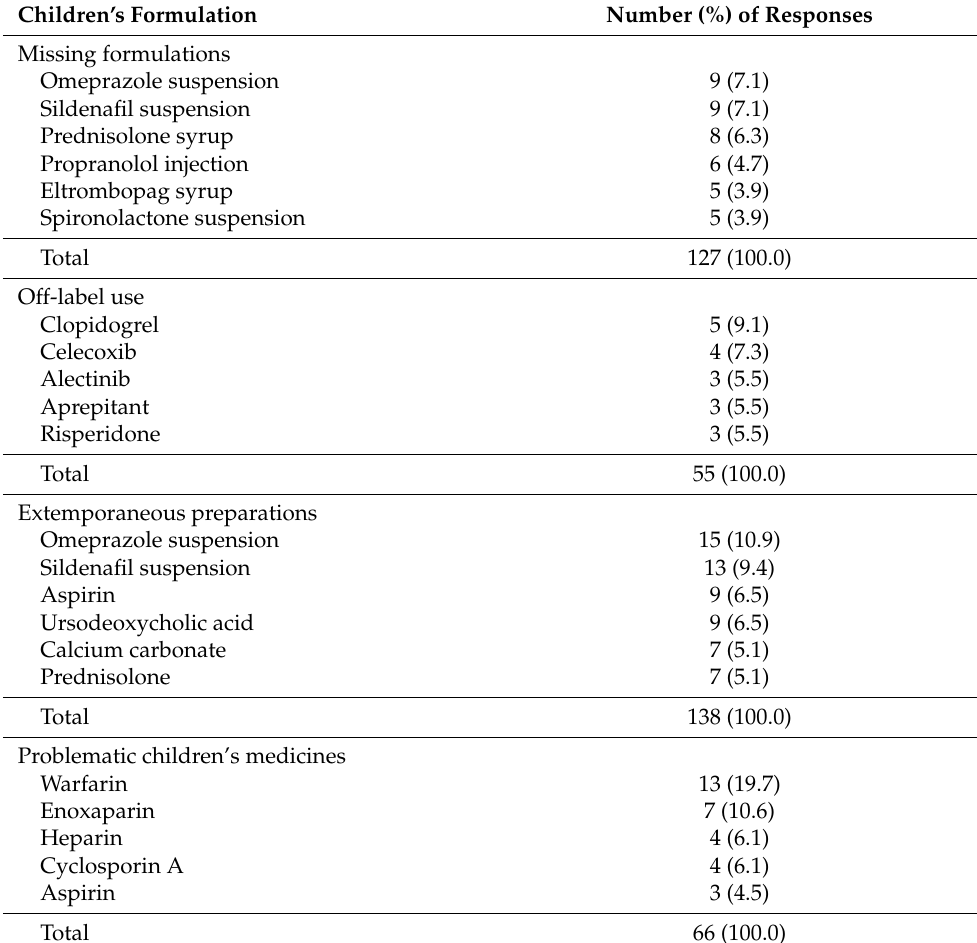
Table 4. Most needed children’s formulations are unavailable in the hospital, as mentioned by